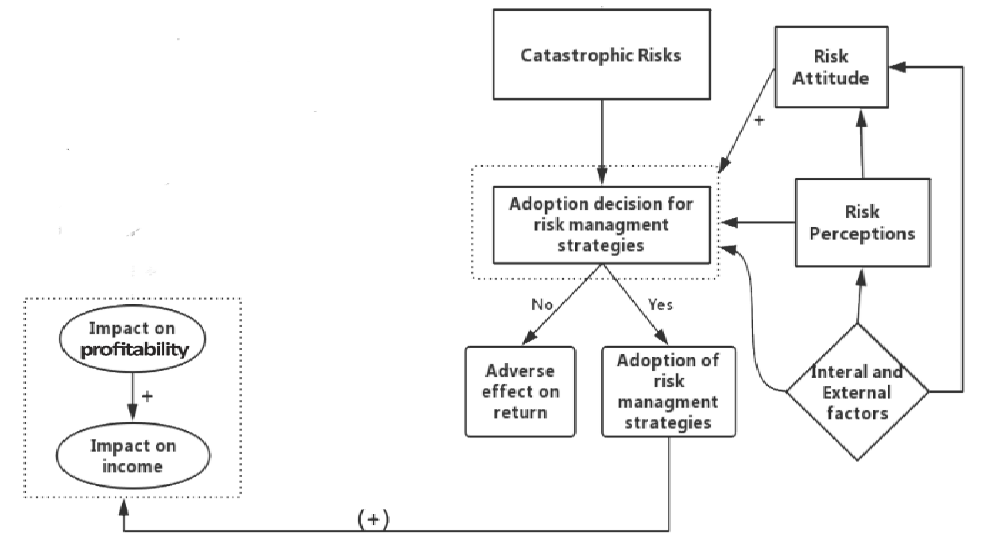
Figure 1. Conceptual framework.